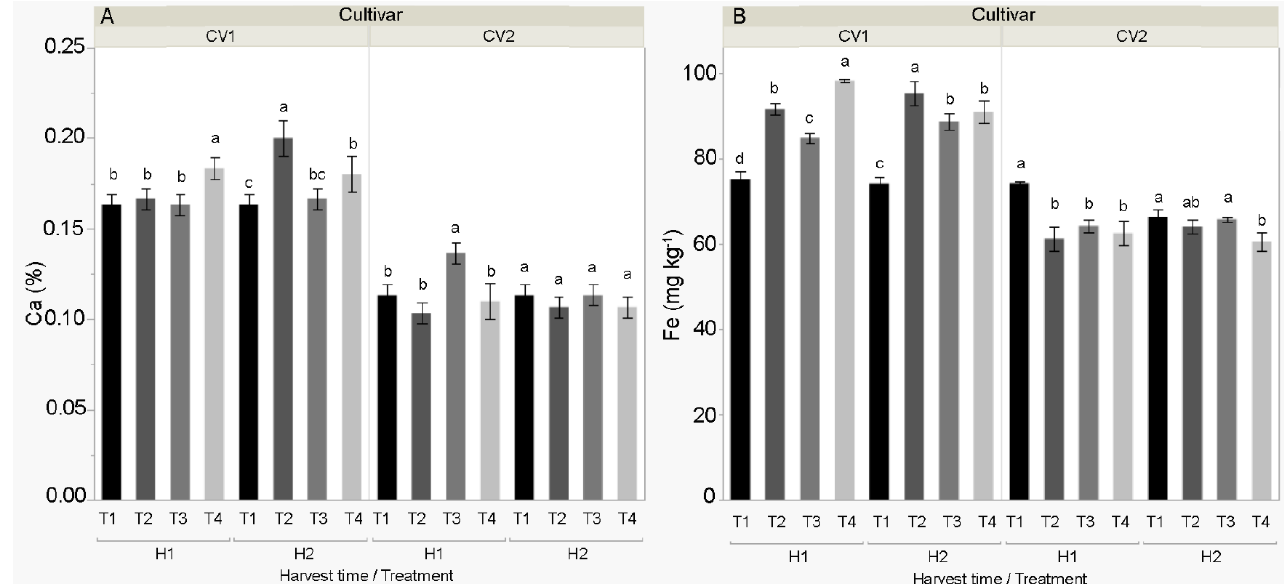
Figure 4. Selected minerals ( A ) calcium (Ca, %) and ( B ) iron (Fe, mg kg −1 ) of sweet pepper cultivars CV1 (Šorokšari) and CV2 (Kurtovska kapija) fruits in H1 (first harvest at technological maturity) and H2 (second harvest at physiological maturity). The T1 (control), T2 (Eco Green, calcite nanoparticles at lower concentration), T3 (Eco Green, calcite nanoparticles at higher concentration), and T4 (Zeogreen+P, calcite-based foliar fertilizer) were applied three times during vegetation on sweet pepper plants. Post hoc comparisons of the means were performed using Tukey’s HSD test at p < 0.05; different letters indicate significant differences among treatments within each measurement time.